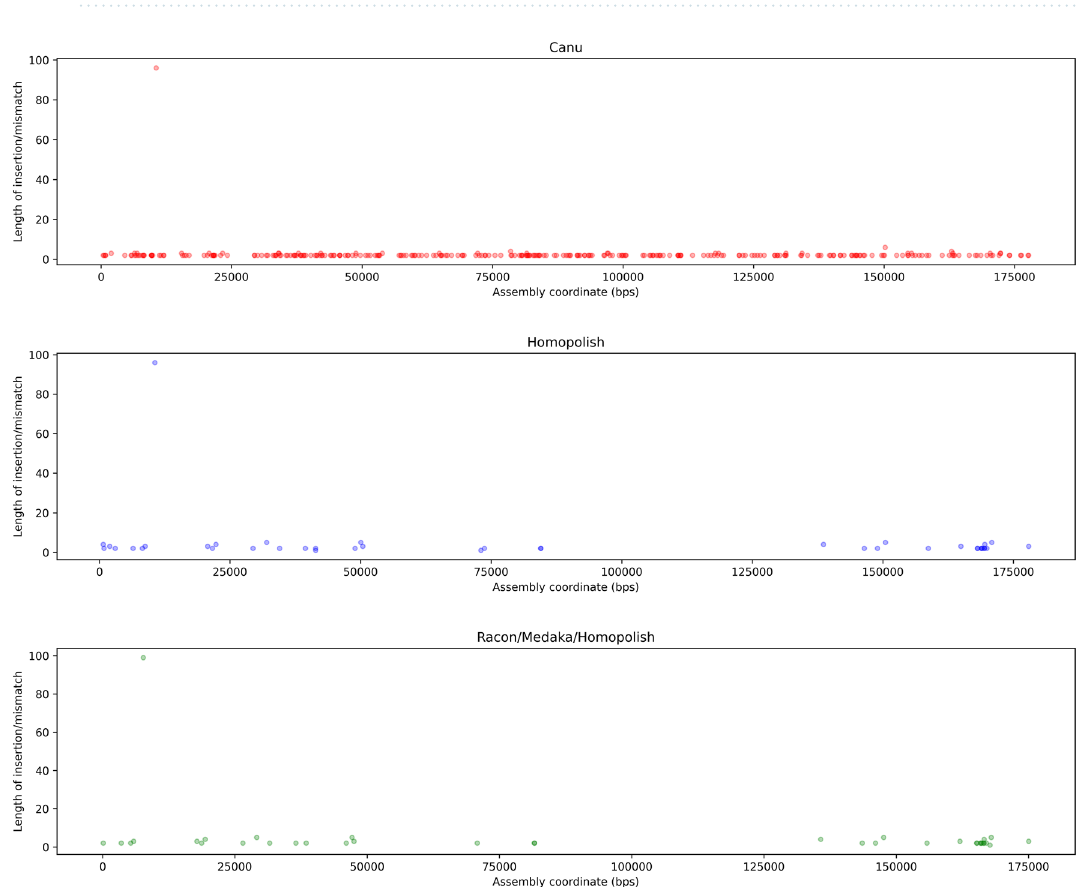
Figure 7. Scatterplot showing effect of polishing using Homopolish (all polymer